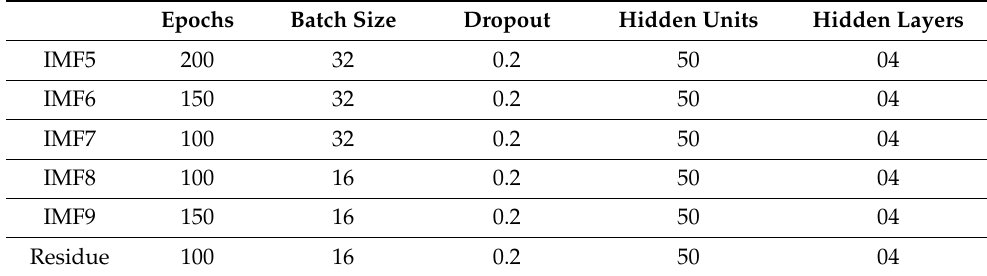
Table 7. Hyper-parameters of EMD-LSTM model.